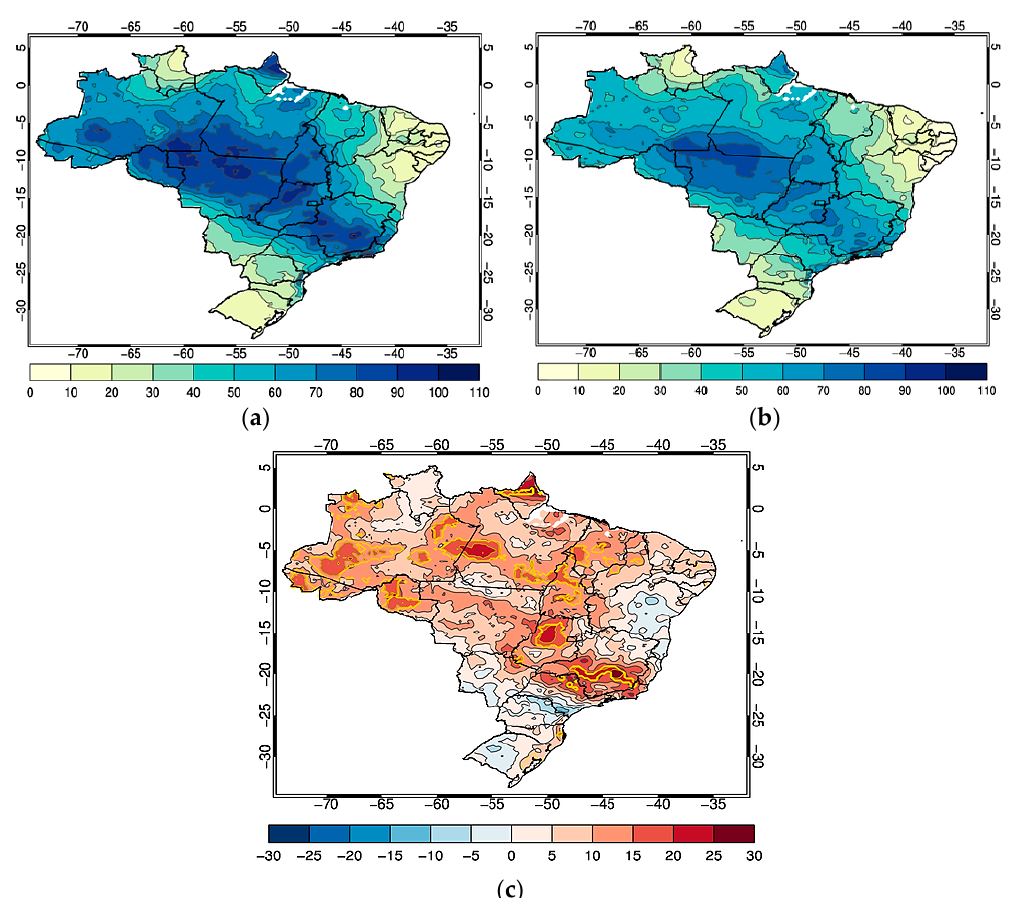
Figure 5. Composite of accumulated precipitation (mm/event) during SACZ events at ( a ) AAO+, ( b ) AAO − , and ( c ) difference between ( a , b ). Yellow outlines in bold indicate values that were statistically significant at the 5% level.